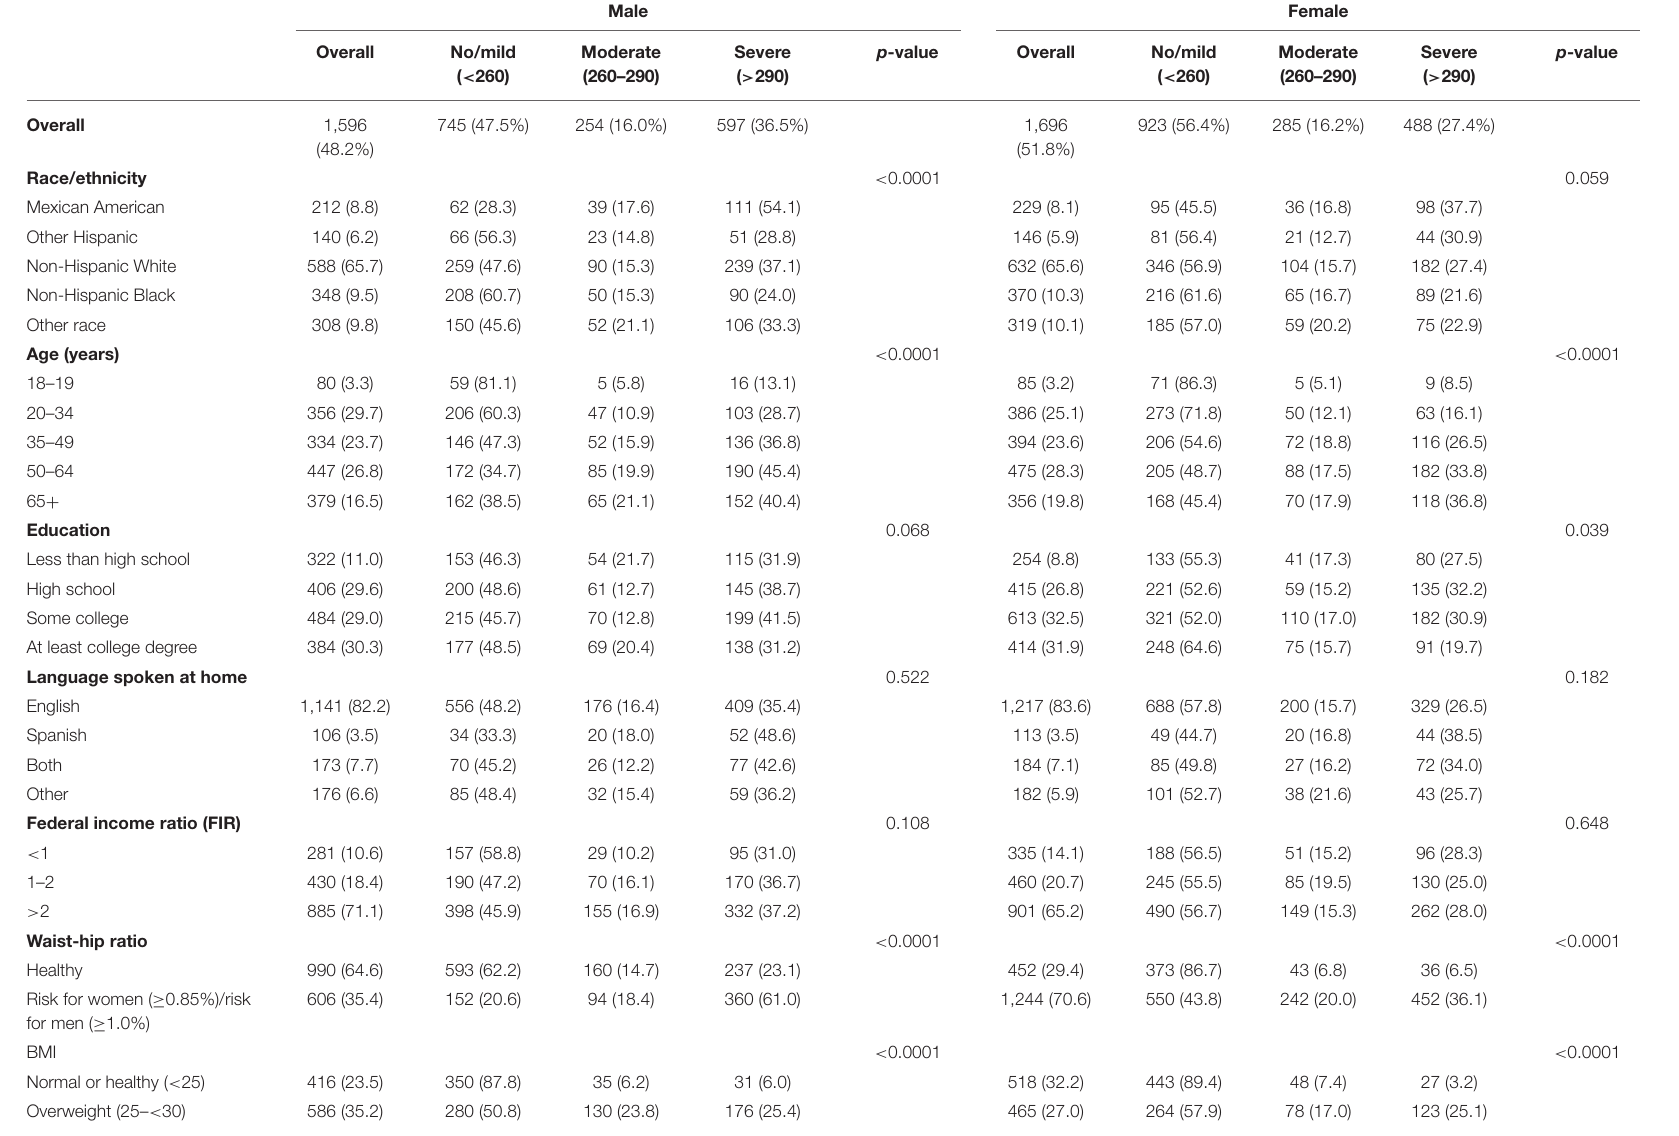
TABLE 2 | Prevalence of NAFLD stages among male and